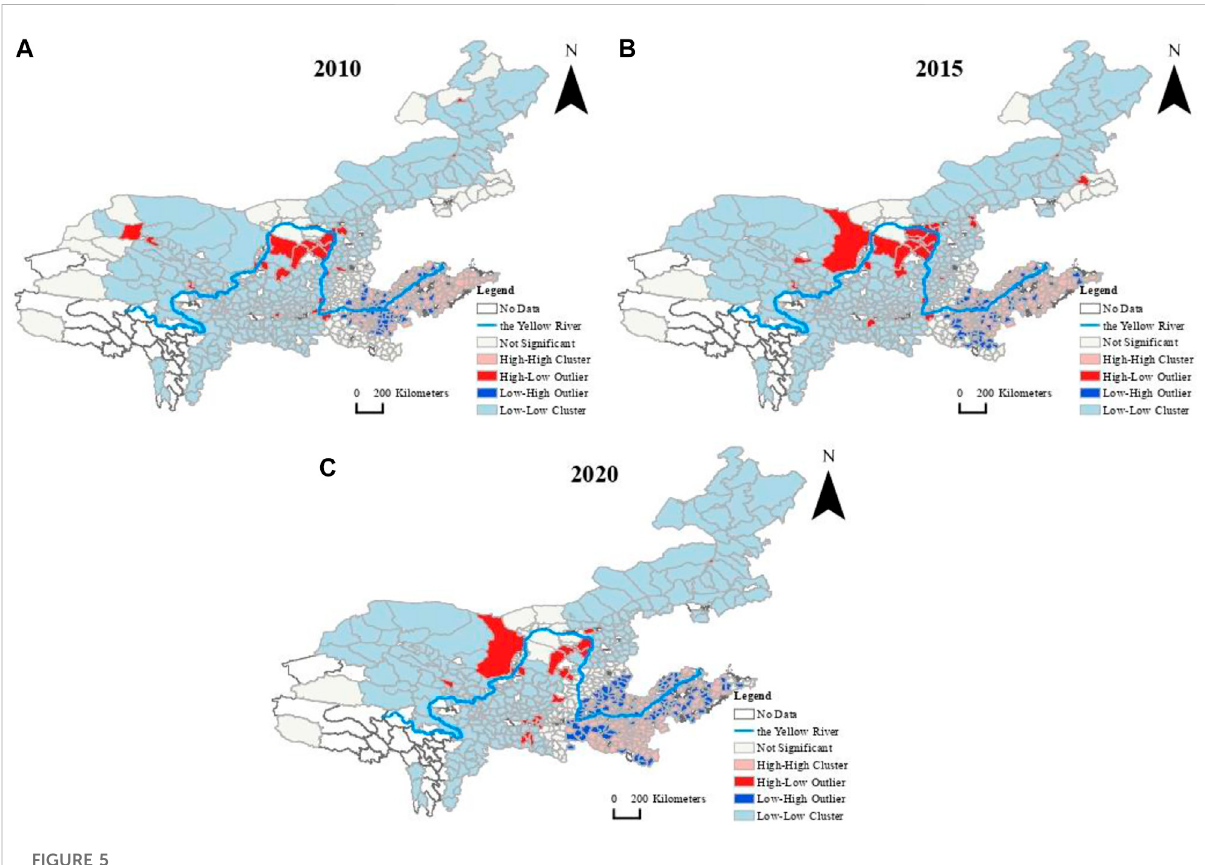
FIGURE 5 Industrial agglomeration map in the YRB in 2010 (A) , 2015 (B) , and 2020 (C)